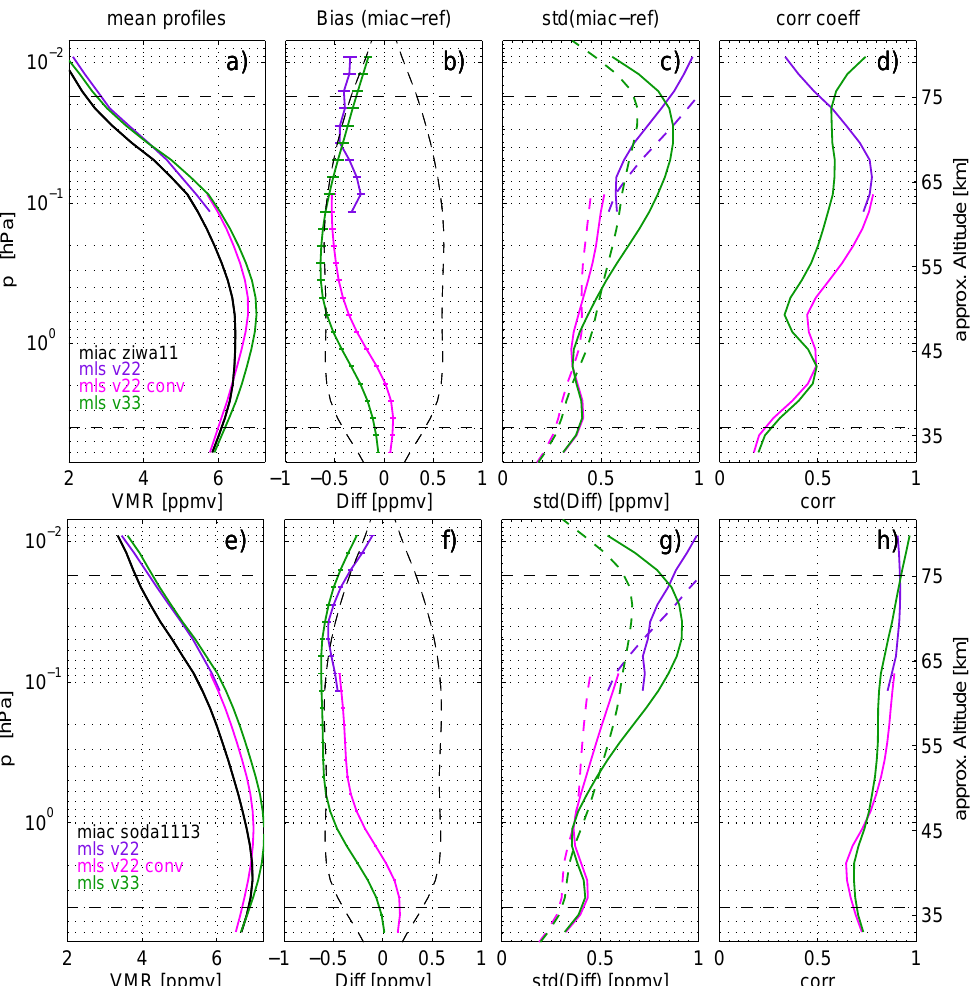
Fig. 10. Intercomparison MIAWARA-C (with dual-polarisation receiver) – MLS for Zimmerwald11 (a–d) and for Sodankyl¨a11–13 (e–h) . (a, e) Mean coincident profiles of MLS v2.2 (pink: convolved, purple: interpolated), MLS v3.3 (green) and MIAWARA-C (black). (b, f) Bias (solid) with standard error (horizontal) with respect to MLS v2.2 (pink: convolved, purple: interpolated) and MLS v3.3 (green) together with the estimated systematic error of MIAWARA-C (black dashed). (c, g) Standard deviation of differences (solid; pink for MLS v2.2 convolved, purple for MLS v2.2 interpolated, green for MLS v3.3) and combined random error of the instruments (dashed). (d, h) Correlation coefficients. All plots use MIAWARA-C data with AoA > 0.5. The dashed horizontal lines indicate the reliable altitude range (AoA >